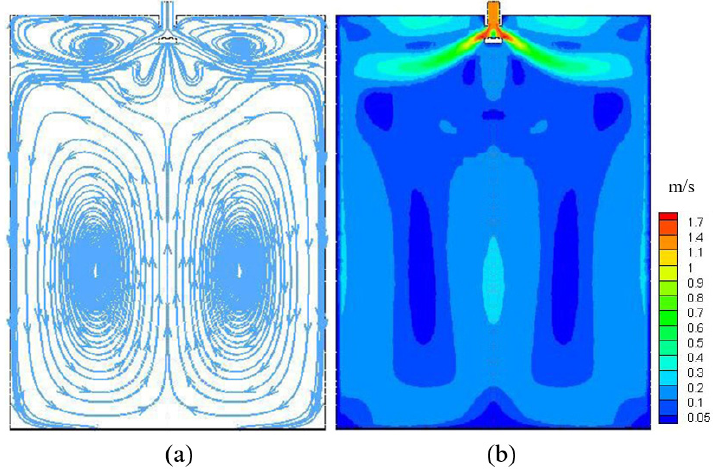
Figure 12. Fluid contours: ( a ) trajectory line; and ( b ) flow field at a 2300 mm width.